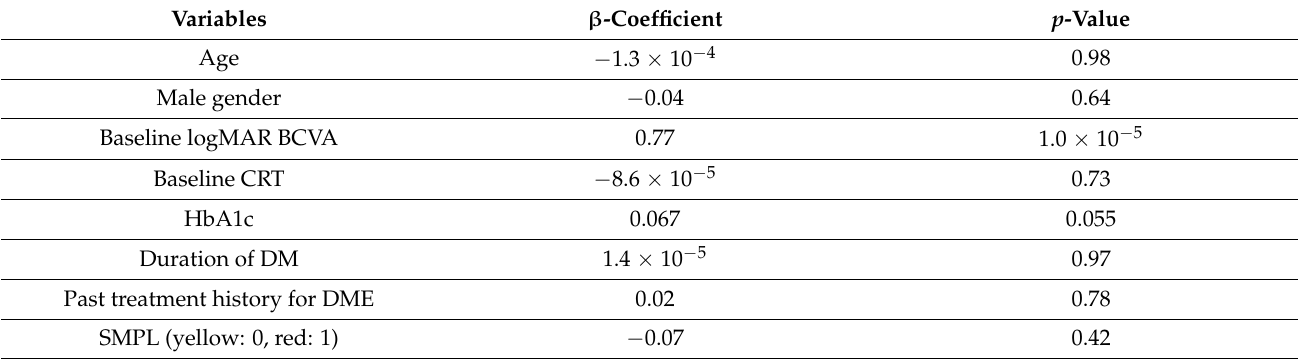
Table 2. Multivariate linear regression analysis of factors associated with mean BCVA at 12